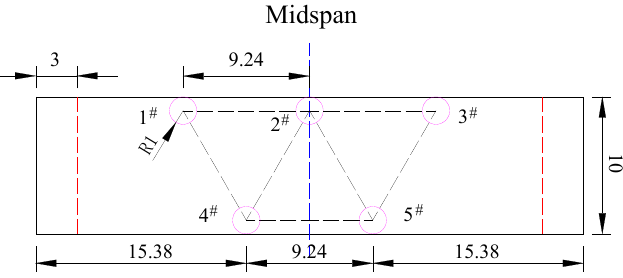
Figure 5. The arrangement of acoustic emission (AE) sensors (unit: cm).